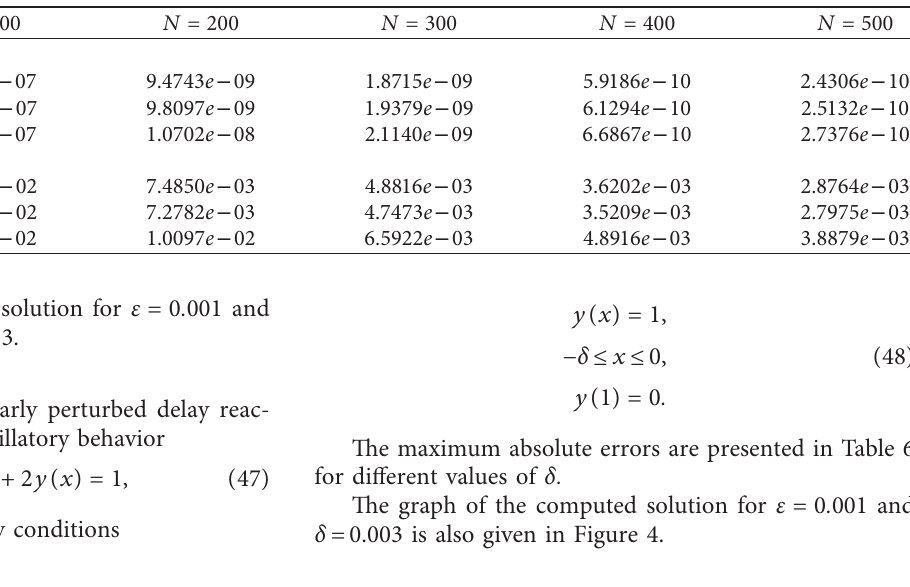
Table 6: The maximum absolute errors of Example 4 for different values of δ with ε � 0 .